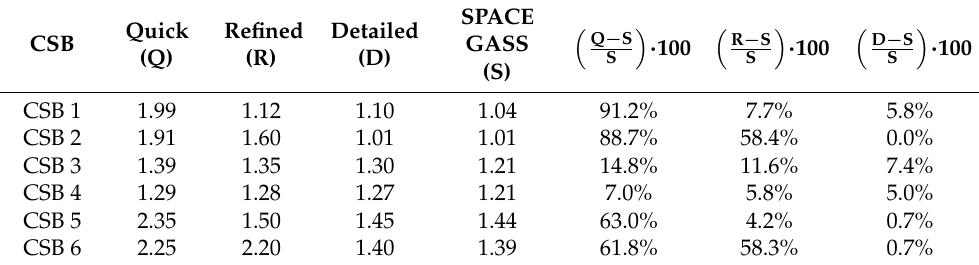
Table 3. Comparison of the edge displacement ratio of the six case study buildings determined using proposed simplified methods and SPACE GASS (dynamic